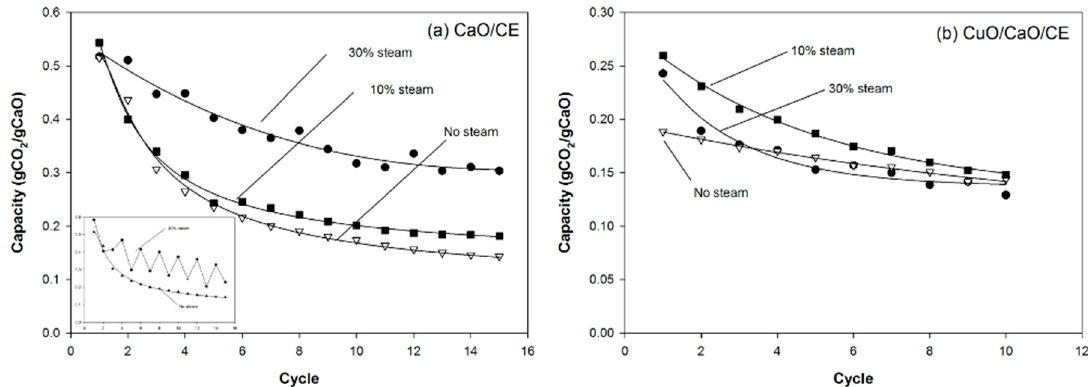
Figure 7. Impact of different steam concentrations during carbonation on the performance of ( a ) CaO/CE pellets over multiple CaL cycles; and ( b ) CuO/CaO/CE pellets over multiple CaL and CLC cycles. The inset in Figure 7a demonstrates the fluctuations in performance when using 30% steam with the CaO/CE pellets.